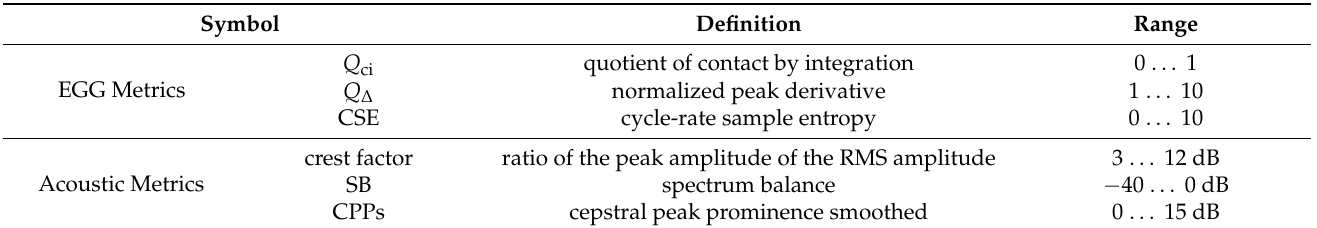
Table 1. The chosen EGG and acoustic metrics as inputs and their typical ranges. Symbol Definition Range Q ci quotient of contact by integration 0 . . . 1 EGG Metrics Q ∆ normalized peak derivative 1 . . . 10 CSE cycle-rate sample entropy 0 . . . 10 crest factor ratio of the peak amplitude of the RMS amplitude 3 . . . 12 dB Acoustic Metrics SB spectrum balance − 40 . . . 0 dB CPPs cepstral peak prominence smoothed 0 . . . 15